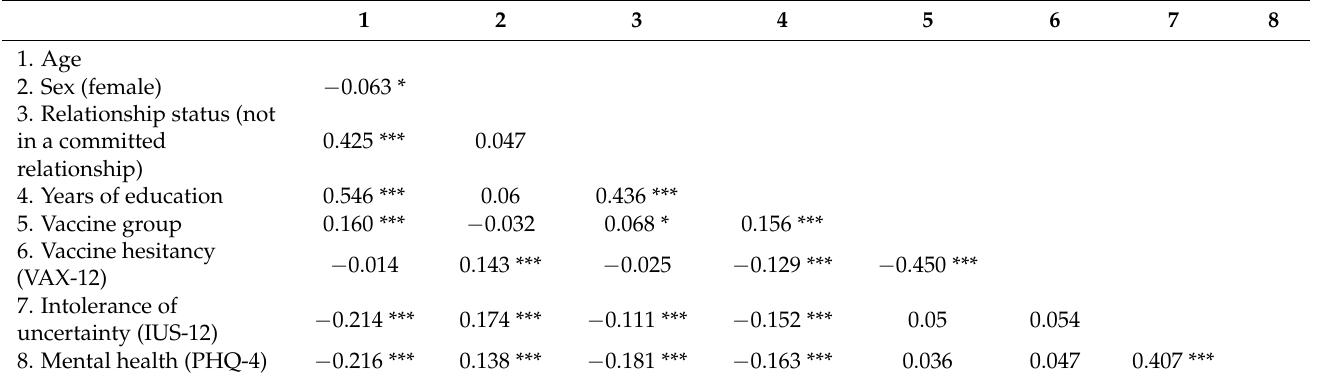
Table 1. Bivariate correlations among the study variables ( n = 1068) a